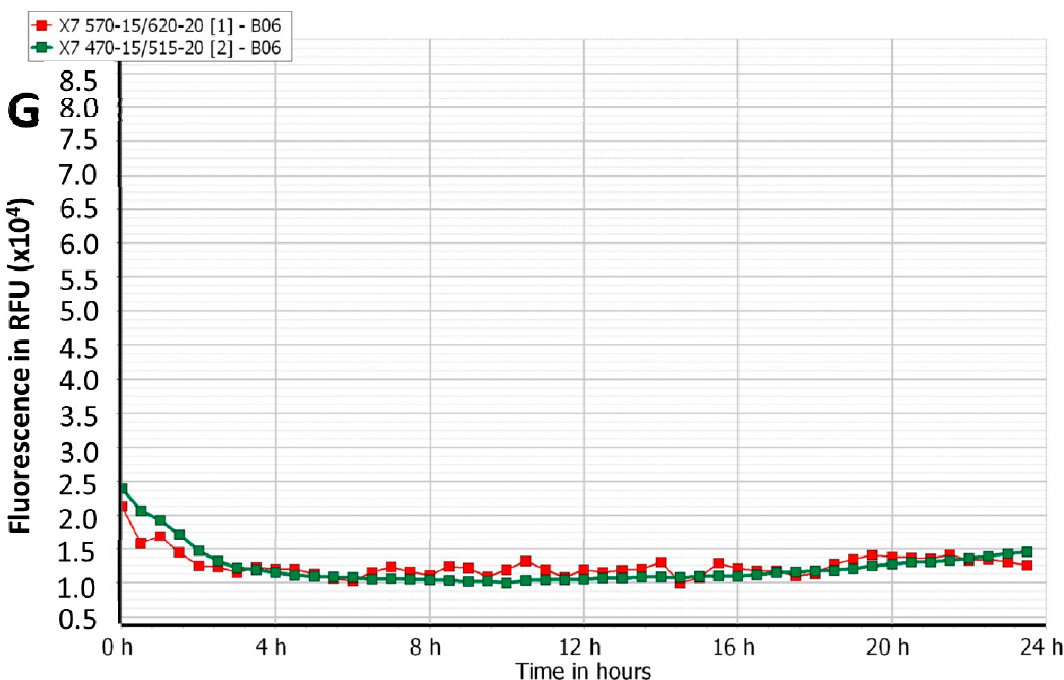
Figure 2. A – G: e ff ect of phage cocktails on mCherry S. aureus KUB7 (red data points) and GFP P. aeruginosa PAO1 (green data points) single- and mixed-species planktonic cultures. RFU represents relative fluorescence unit. ( A ) PBS-treated mCherry S. aureus KUB7 (in red) single-species culture; the green graph is due to background detection since the machine was set for mCherry and GFP detection. ( B ) PBS-treated GFP P. aeruginosa PAO1 (in green) single-species culture; the red graph is due to background detection since the machine was set for mCherry and GFP detection. ( C ) PBS-treated mCherry S. aureus KUB7 and GFP P. aeruginosa PAO1 mixed-species culture. ( D ) AB-SA01-treated mCherry S. aureus KUB7 and GFP P. aeruginosa PAO1 mixed-species culture. ( E ) AB-PA01-treated mCherry S. aureus KUB7 and GFP P. aeruginosa PAO1 mixed-species culture. ( F ) AB-PA01 + AB-SA01-treated mCherry S. aureus KUB7 and GFP P. aeruginosa PAO1 mixed-species culture. ( G ) Gentamicin-treated mCherry S. aureus KUB7 and GFP P. aeruginosa PAO1 mixed-species culture.